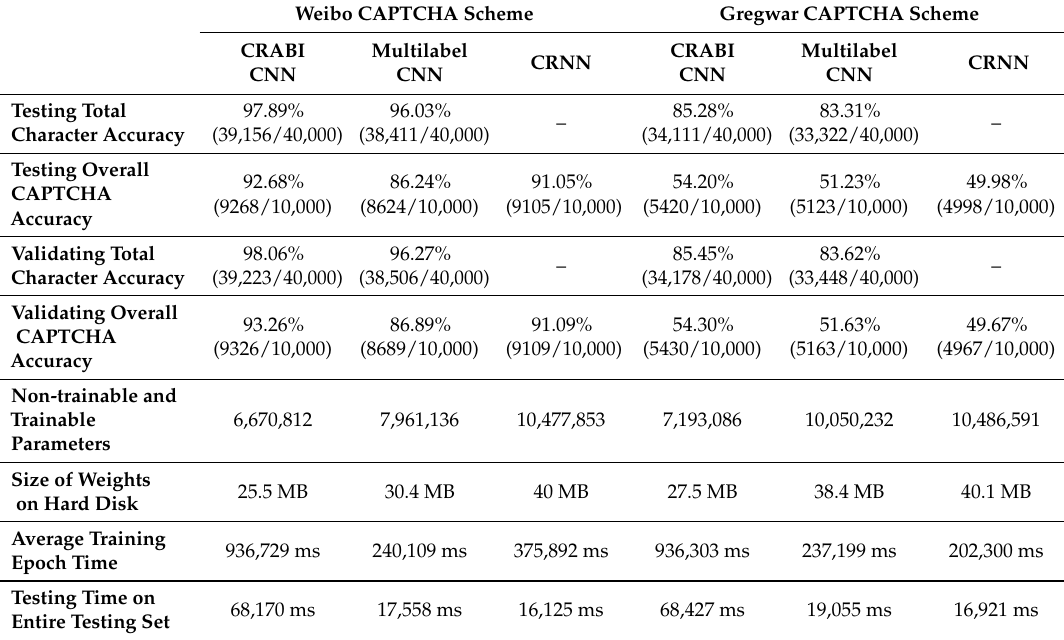
Table 3. Comparison